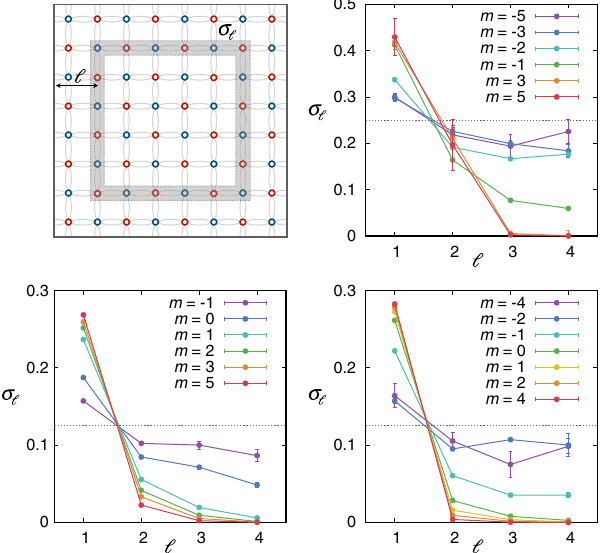
FIG. 9. Surface charge density evaluated in an 8 × 8 system as sketched in the top-left image. The shaded region represents the domain D l defined in the main text. TTN simulations have been performed for different charge sectors and electric couplings; in = 2 ¼ 2 Þ , ð Q ¼ − 8 ; g 2 = 2 ¼ 2 Þ , clockwise order, ð Q ¼ − 16 ; g 2 e e = 2 ¼ 1 = 2 Þ . and ð Q ¼ − 8 ; g 2 e smoothened out with an exponentially small density-charge tail penetrating into the bulk. The overall scenario is con- firmed by the field plots in Figs. 7 and 8, where it is pretty clear that when the couplings are tuned in order for the system to be deep in the vacuum regime, the excess charges stick to the boundary so as to minimize the length of the attached electric strings. In principle, all possible configurations with all charges at the boundaries are energetically equivalent. However, the TTN many-body wave function spontaneously breaks such symmetry and picks up a single, specific